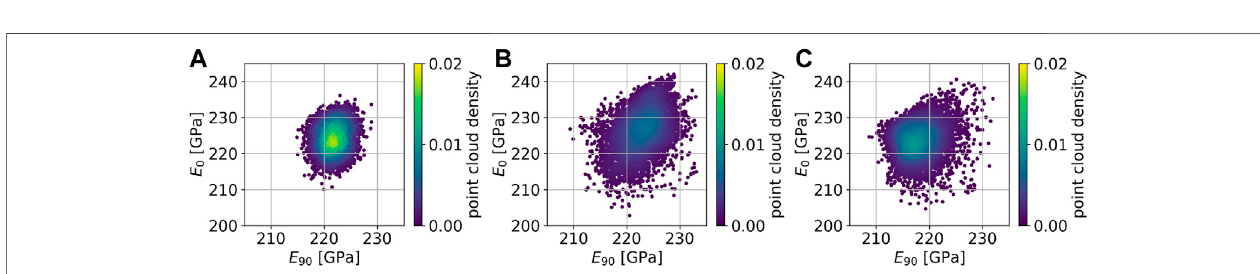
FIGURE 6 | Illustration of the texture identi fi cation problem. The space of rolling textures is described by d j and the space of properties by p j .